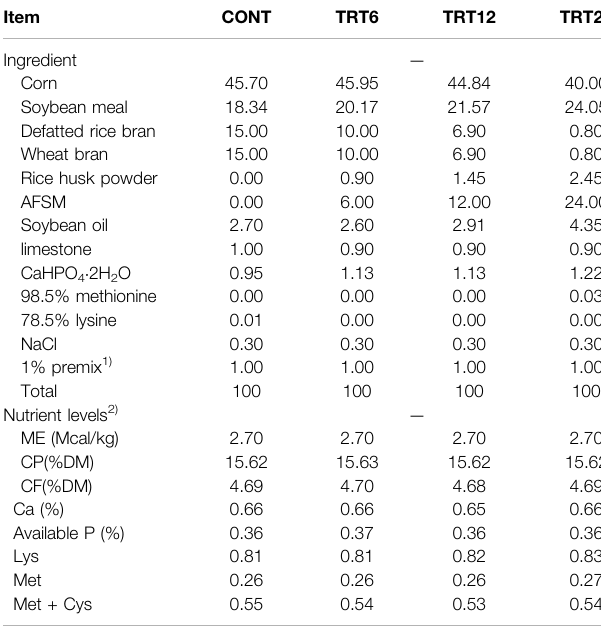
TABLE 1 | Nutrient composition of alfalfa-mixed silage fermentation material (AMSFM). Item